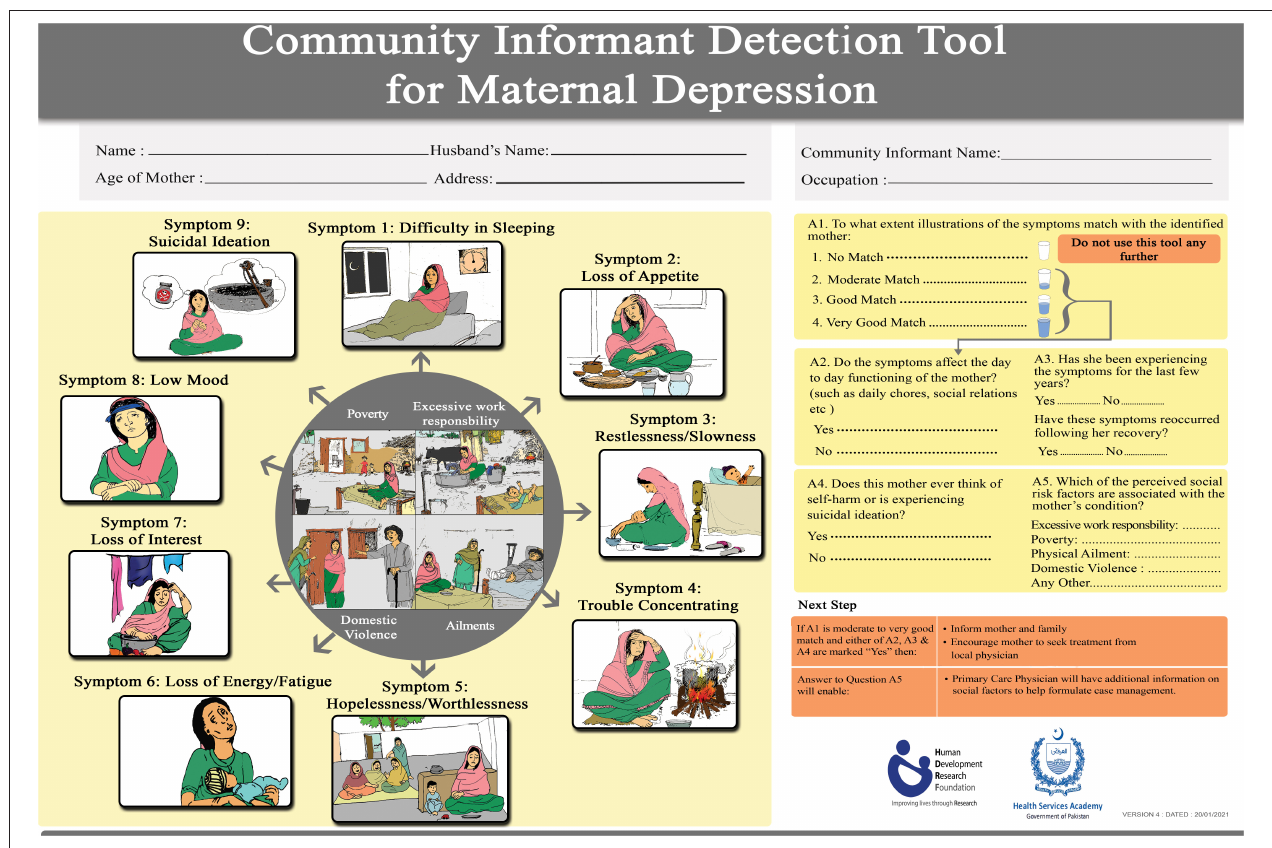
FIGURE 2 | Community informant detection tool for maternal depression